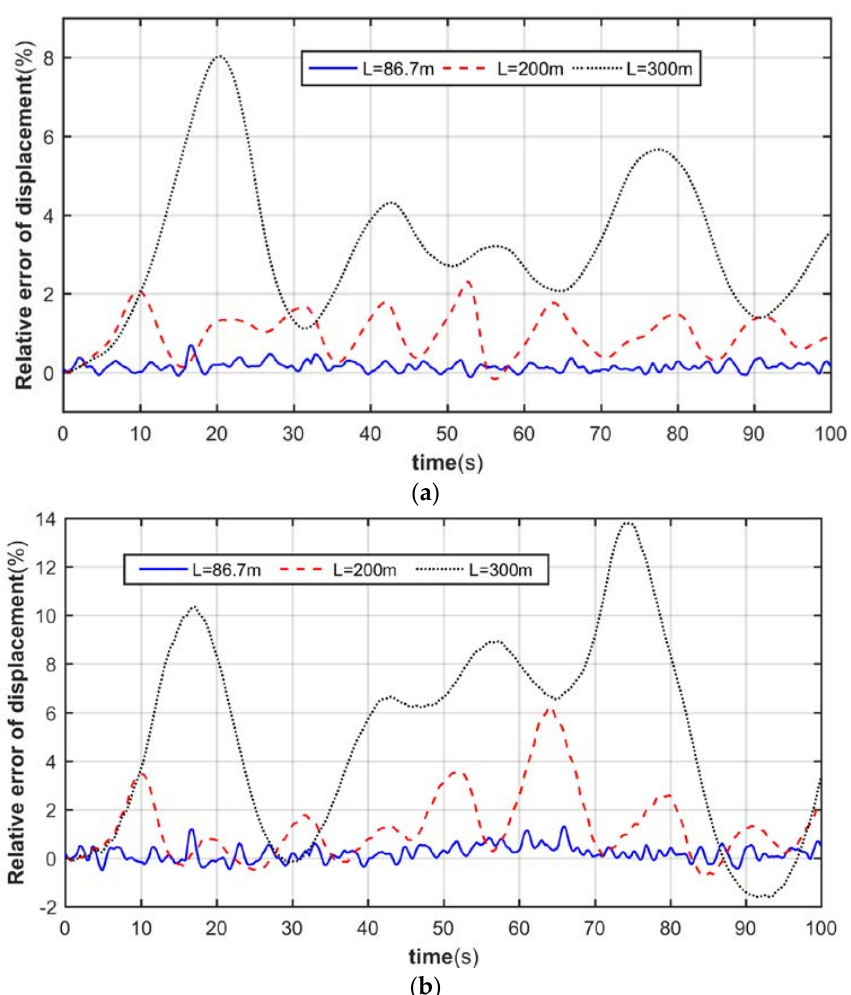
Figure 10. Relative error of tower top displacement. ( a ) Longitudinal direction. ( b ) Crosswind di ‐ rection.